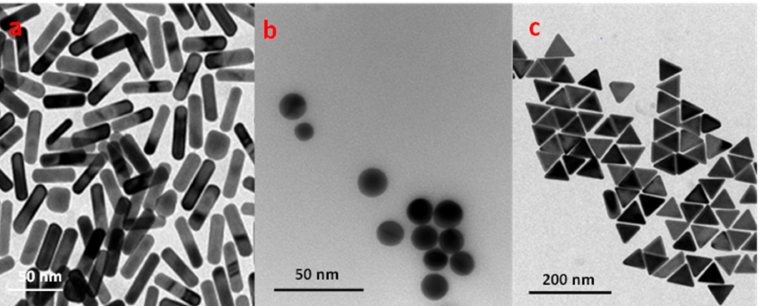
Figure 1. TEM images of Bpy-SH@AuNR ( a ), Bpy-SH@AuNS ( b ) and Bpy-SH@AuNT ( c